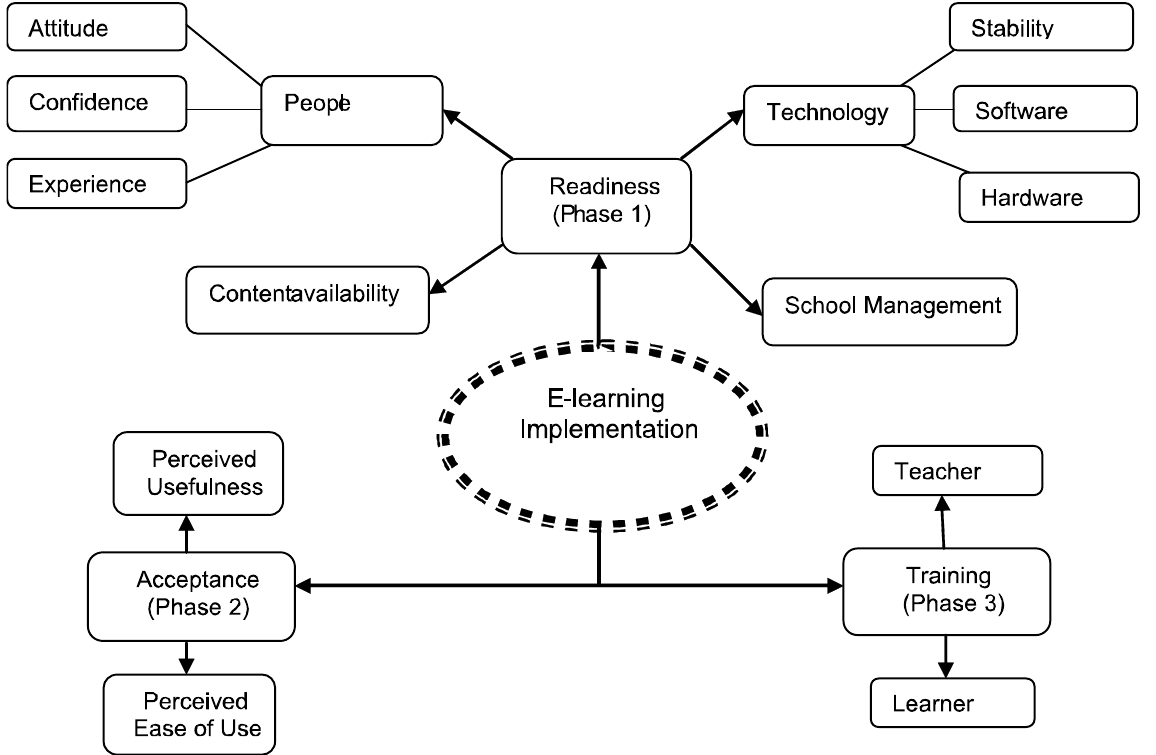
Figure 1. Framework for assessing the level of readiness to implement e ‐ learning (Akaslan & Law,